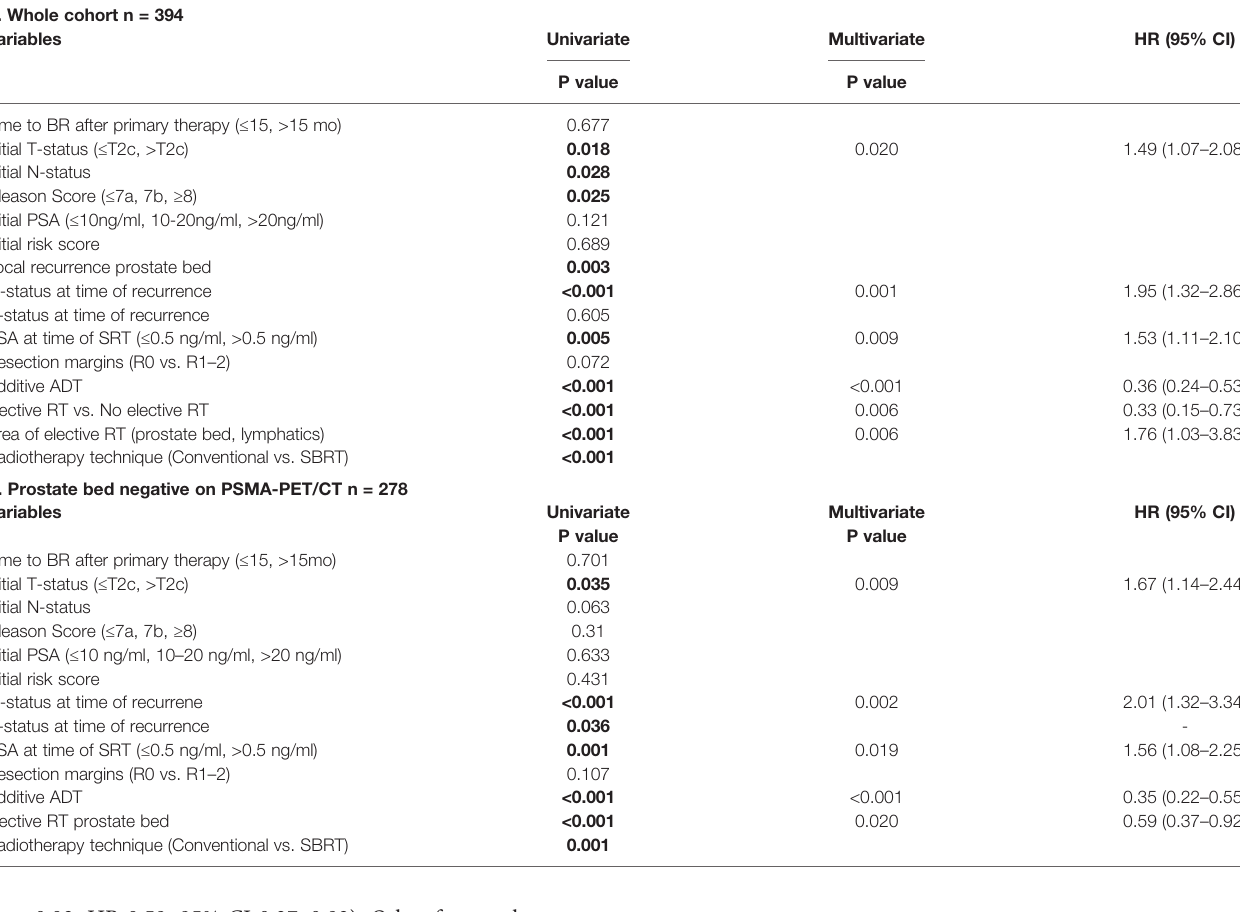
TABLE 3 | Univariate and multivariate Cox regression analysis determining independent factors in fl uencing biochemical recurrence-free survival for (A) whole cohort and (B) Prostate bed negative on